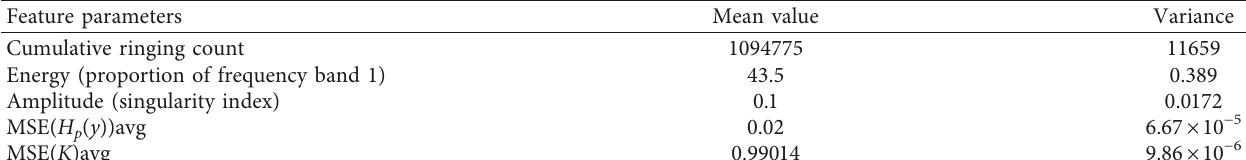
Figure 12: Variations of the cumulative ringing count, the proportion of frequency band 1, and the amplitude singularity index. Table 2: Mean value and variance of the magnetic-acoustic feature parameters (1000